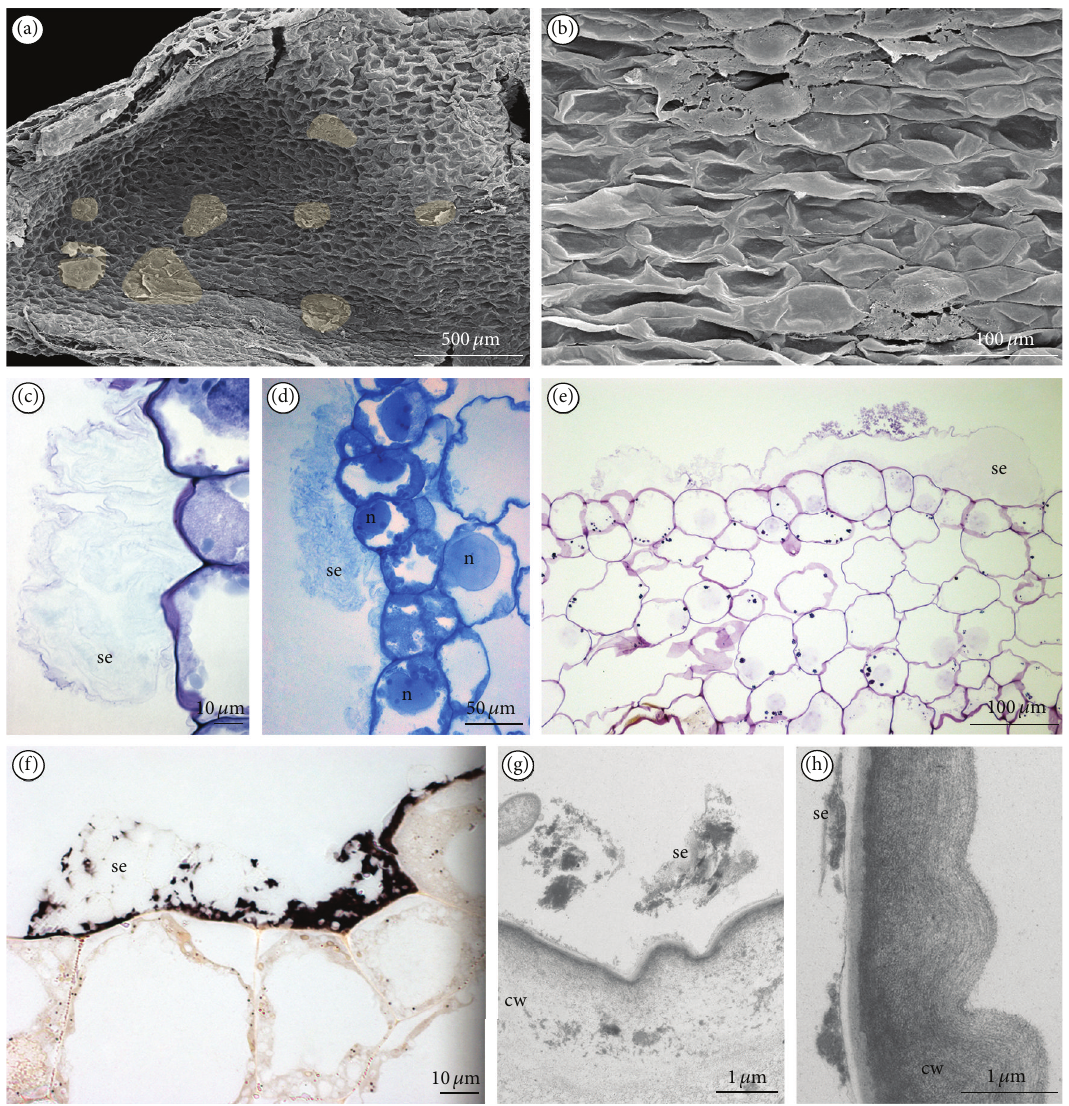
Figure 6: Lip spur: (a) adaxial (inner) surface of spur with places of secretion ( yellow ) at the apex of the spur, the 6th day of anthesis (SEM). (b) Places of secretion inside spur, 4th day (SEM). (c) Secretion on the adaxial surface of spur, 2nd day (TBO). (d) Secretion on the adaxial surface of spur stained for proteins; notice large nuclei, 2nd day (ABB). (e) Secretion inside spur stained for polysaccharides insoluble in water, starch grains visible in cells, 5th day (PAS). (f) Secretion on the adaxial surface of spur, stained for lipids (SBB). (g-h) Secretion on the adaxial surface of spur (TEM) (cw: cell wall; se: